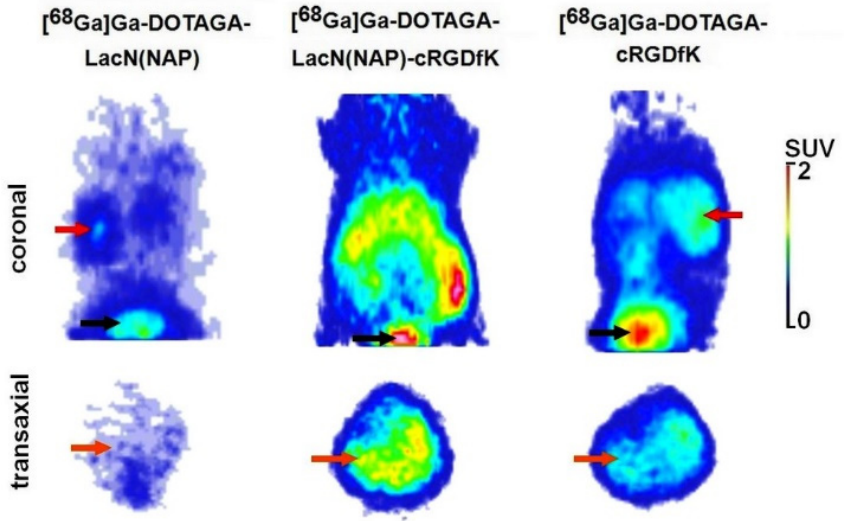
Figure 6. In vivo assessment of [ 68 Ga]Ga-DOTAGA-LacN(NAP), [ 68 Ga]Ga-DOTAGA-LacN(NAP)- cRGDfK, and [ 68 Ga]Ga-DOTAGA-cRGDfK accumulation in healthy control C57BL/6 mice. Representative decay-corrected coronal ( upper row ) and transaxial ( lower row ) PET images were obtained 80 min after intravenous injection of the radiotracers. Red arrows: kidney; black arrows: bladder (urine); orange arrows: liver.